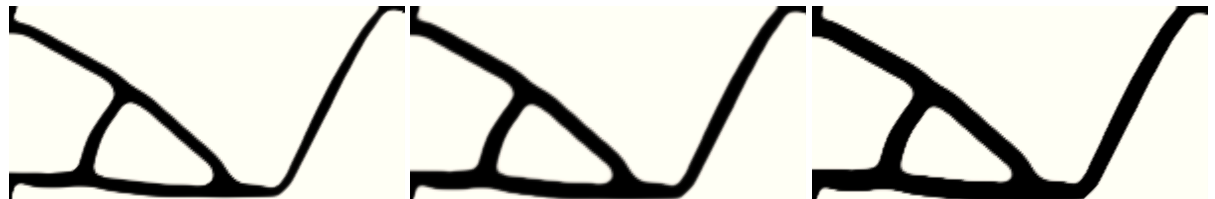
Figure 6. Three threshold projections, eroded, intermediate and dilated, obtained with thresholds η = 0 . 6 , 0 . 5 and η = 0 . 4, respectively. The design is obtained using large displacements robust optimisation formulation with threshold η ∈ U [0 . 2 , 0 . 8] and volume constraint 30% of the original volume imposed on the dilated projection at η = 0 . 2. The objective is E[ c ] = − 6 . 12 µ m, the standard deviation is STD[ c ] = 4 . 00, the number of the integration points is 31, and the projection parameter is β = 32. Journalname